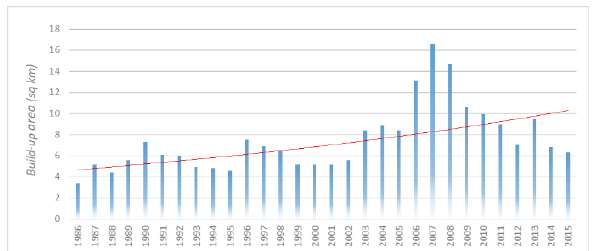
Figure 6 . Evolution of the new built-up area in Bucharest-Ilfov between 1985 and 2015 (data extracted from the WSF Evolution dataset created by DLR)